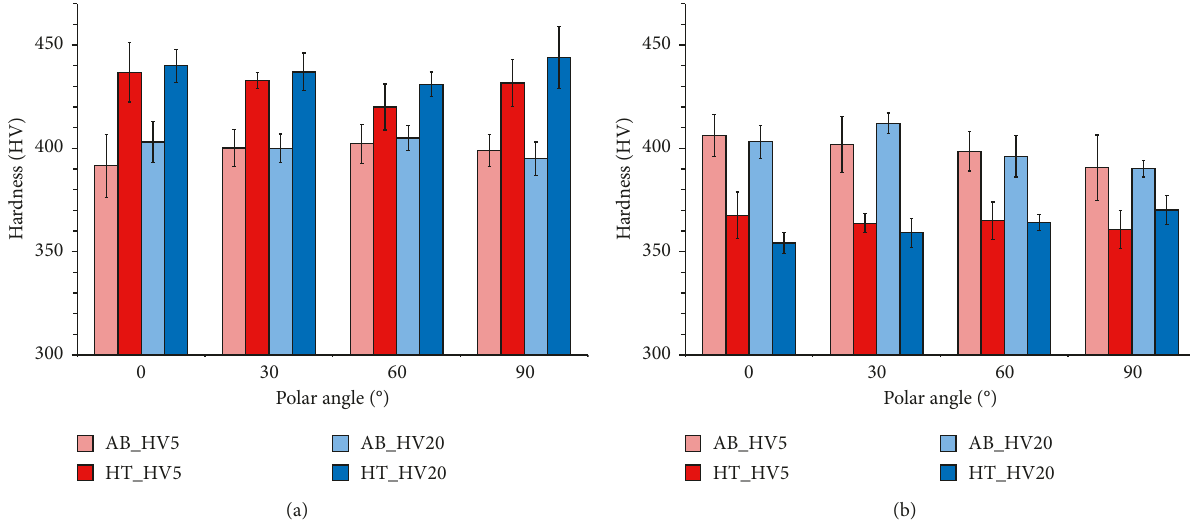
Figure 9: HV5 and HV20 values for Co-Cr-Mo (a) and Co-Cr-W (b) alloys. Error bars show standard deviation from the mean.